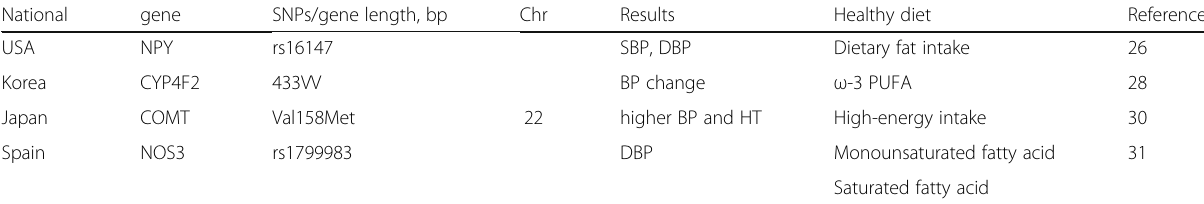
Table 3 Review for interaction of gene and healthy diet on hypertension